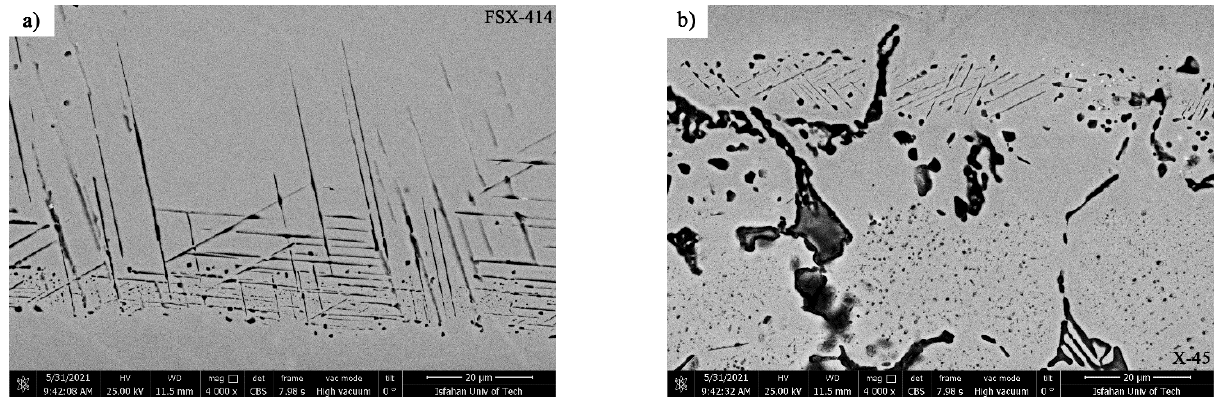
Figure 17. SEM micrographs of the diffusion-affected zone on the side of the ( a ) FSX-414 and ( b ) X-45 with the 1150 °C/10 min bonding condition.